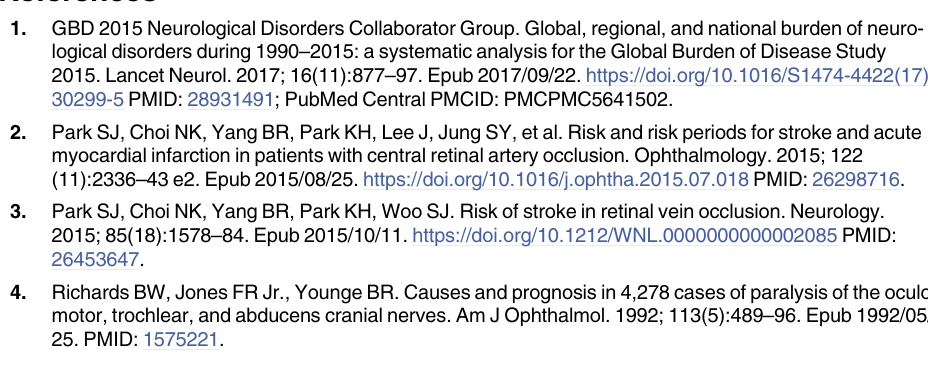
S1 File. (Table A) Results of Time-varying Cox Regression Models (Subgroup Analysis #1) for Incident Stroke in the Eligible Population with Third Nerve Palsy as the Time-varying Covari- ate. (Table B) Results of Time-varying Cox Regression Models (Subgroup Analysis #1) for Incident Stroke in the Eligible Population with Fourth Nerve Palsy as the Time-varying Covar- iate. (Table C) Results of Time-varying Cox Regression Models (Subgroup Analysis #1) for Incident Stroke in the Eligible Population with Sixth Nerve Palsy as the Time-varying Covari- ate. (Table D) Results of Time-varying Cox Regression Models (Subgroup Analysis #2) for Ischemic Stroke in the Eligible Population. (Table E) Results of Time-varying Cox Regression Models (Subgroup Analysis #2) for Hemorrhagic Stroke in the Eligible Population. (Table F) Demographics and Characteristics of Patients with Incident Cranial Nerve Palsy and Propen- sity Score-based Matched Population (1:10) in the Sensitivity Analysis. (Table G) Results of Time-varying Cox Regression Models for Incident Stroke in the Propensity Score-based Sensi- tivity